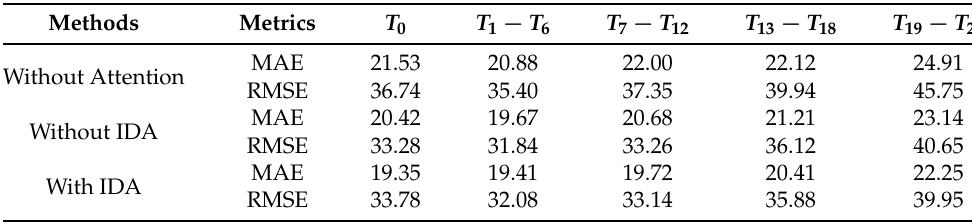
Table 2. Ablation analysis on Inversed Distance Attention (IDA) networks. The values in the table are the MAE and RMSE of AQI